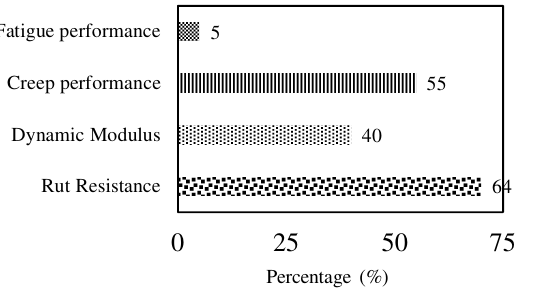
Fig. 11: Percent Improvement in Performances due to PET